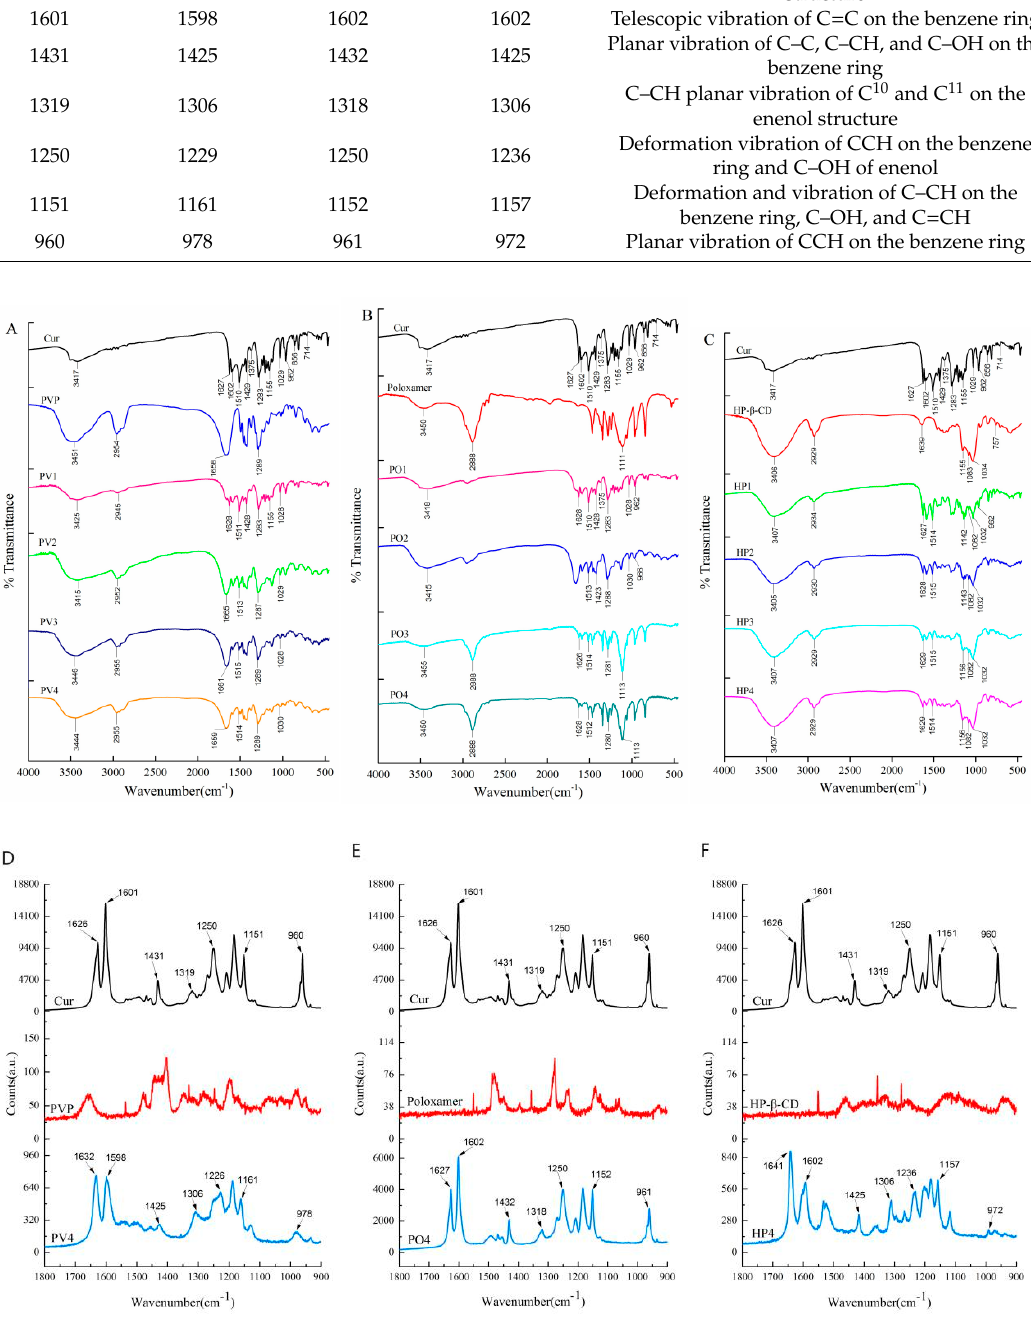
Table 1. The Raman spectrum peak of Curcumin and its solid preparations. Cur (cm − 1 )